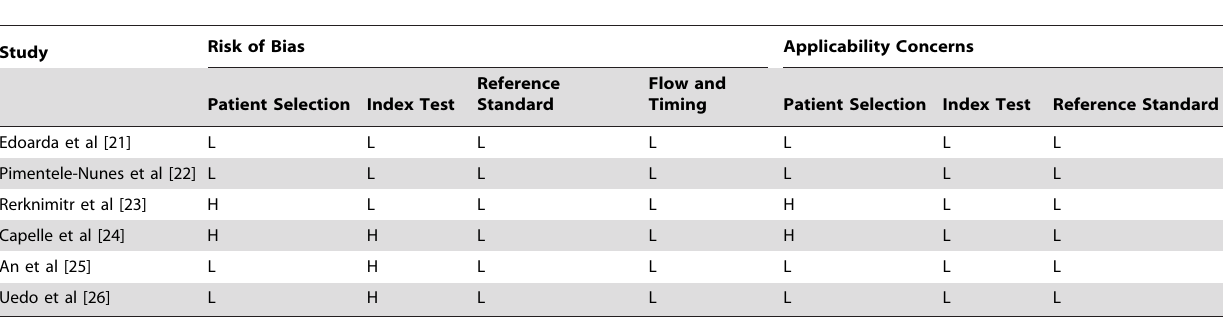
Table 2. The Quality Assessment of Diagnostic Accuracy Studies-2 (QUADAS-2) tool for quality assessment of studies selected for the meta-analysis.